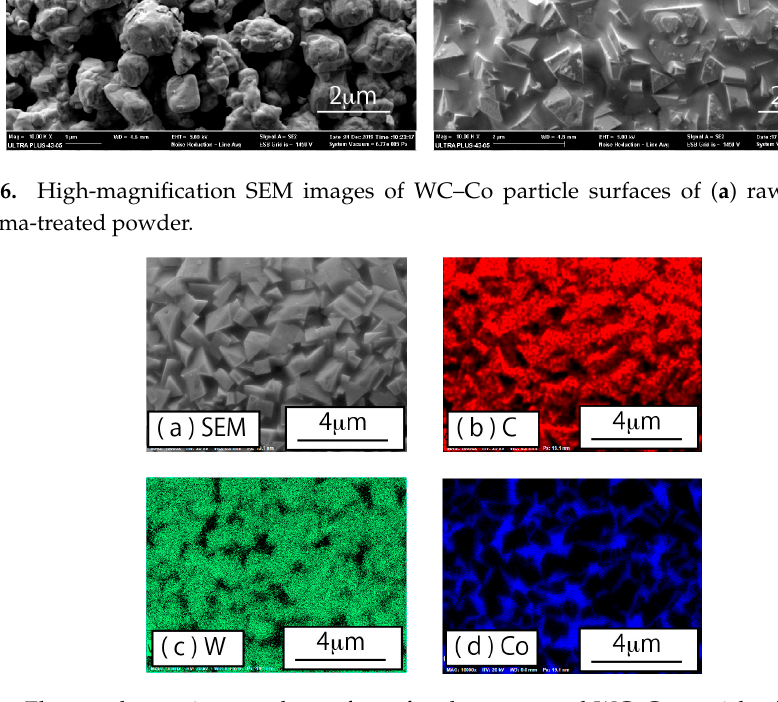
Figure 7. Elemental mappings on the surface of a plasma-treated WC–Co particle: ( a ) SEM image, ( b ) carbon mapping, ( c ) tungsten mapping, and ( d ) cobalt mapping.